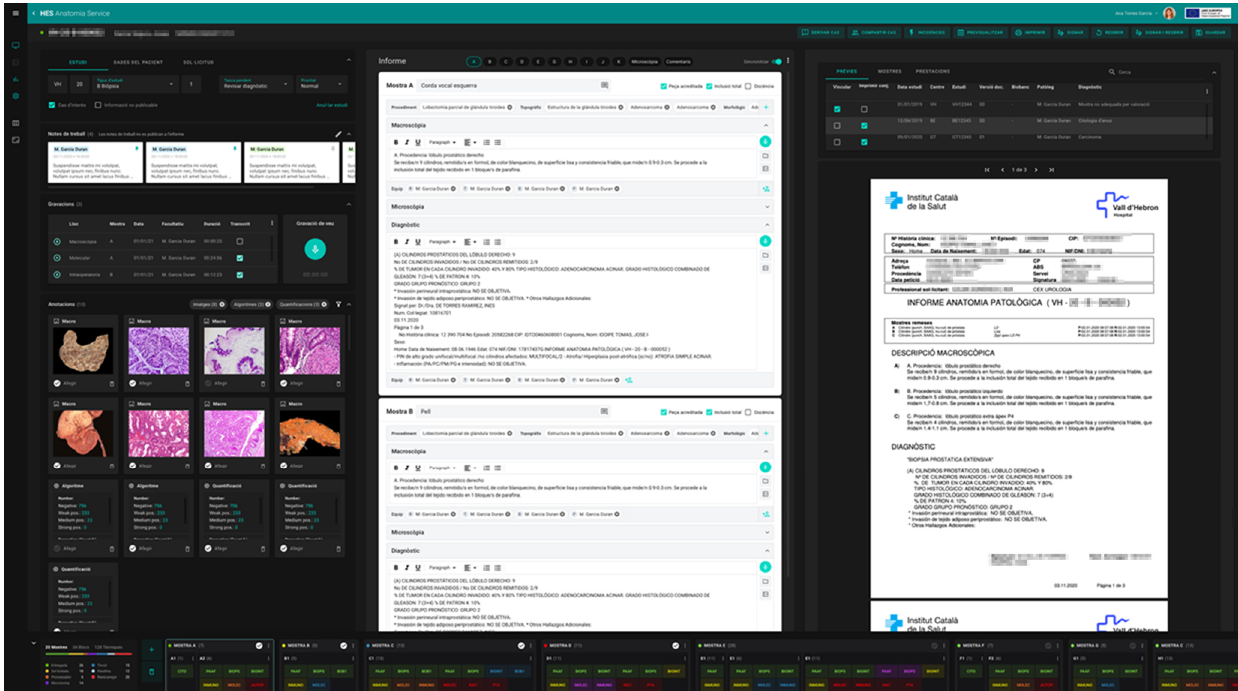
Figure 8. ETPAT screenshot (our proprietary LIS).